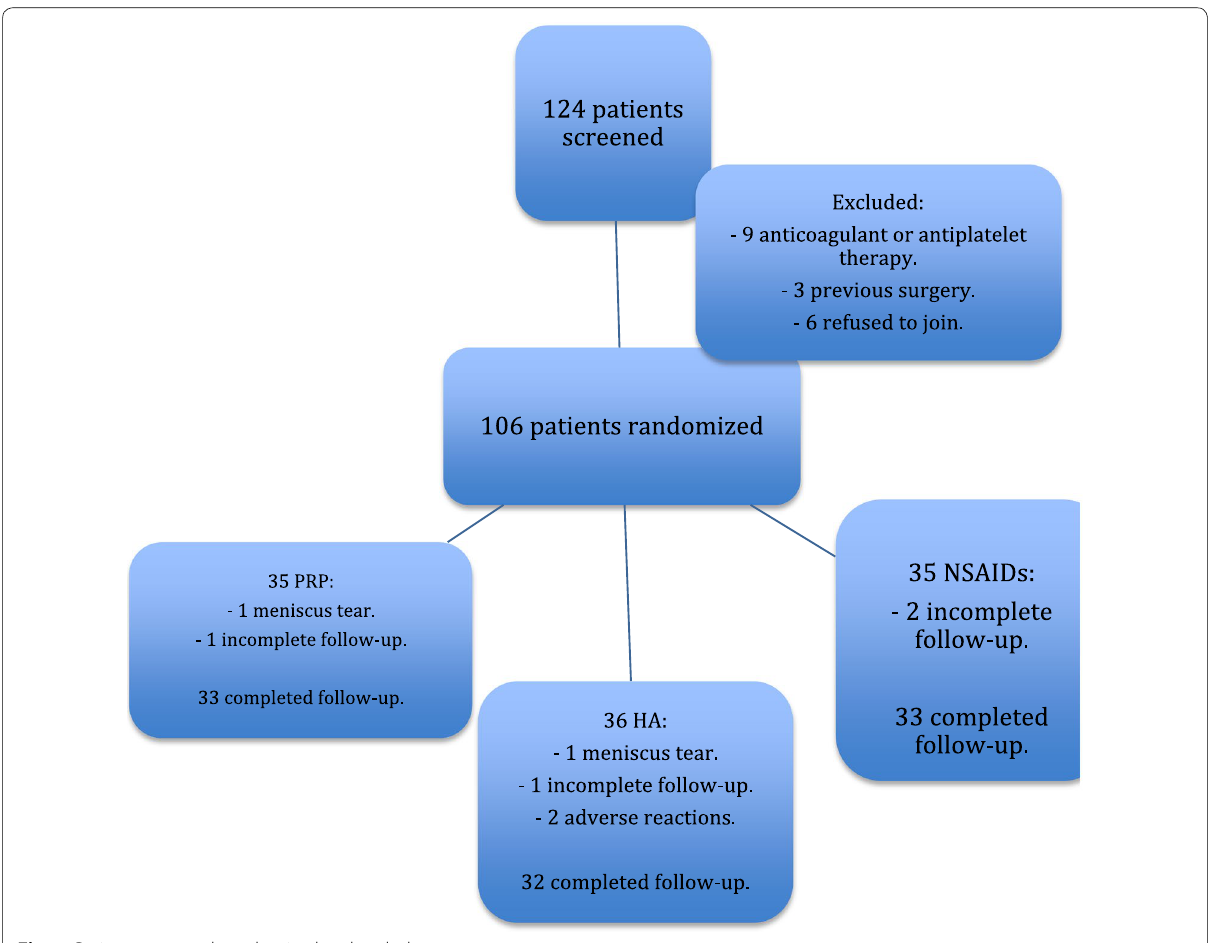
Fig. 1 Patients screened, randomized and